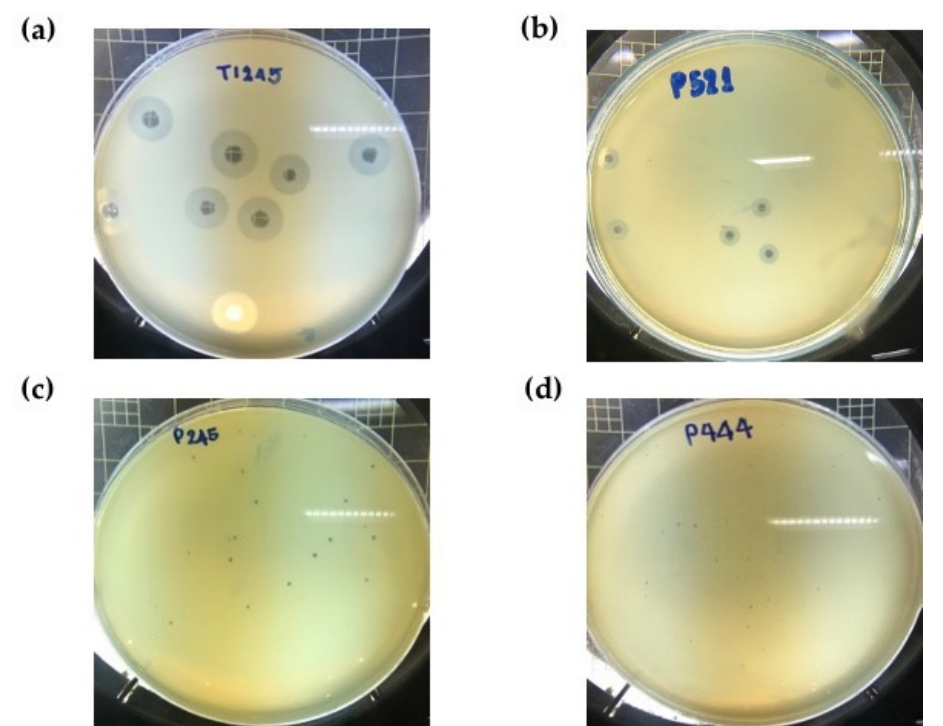
Figure 1. Plaque morphology of phages on different hospital isolates of multidrug-resistant A. baumannii. ( a ) Big and bright plaque (8–10 mm) on KL10 isolate, ( b ) medium-size and bright plaque (5–7 mm) on KL10 isolate, ( c ) small and slightly dim plaque (2–4 mm) on KL6 isolate, and ( d ) extremely small and slightly dim plaque (0.5–1 mm) on KL52 isolate.